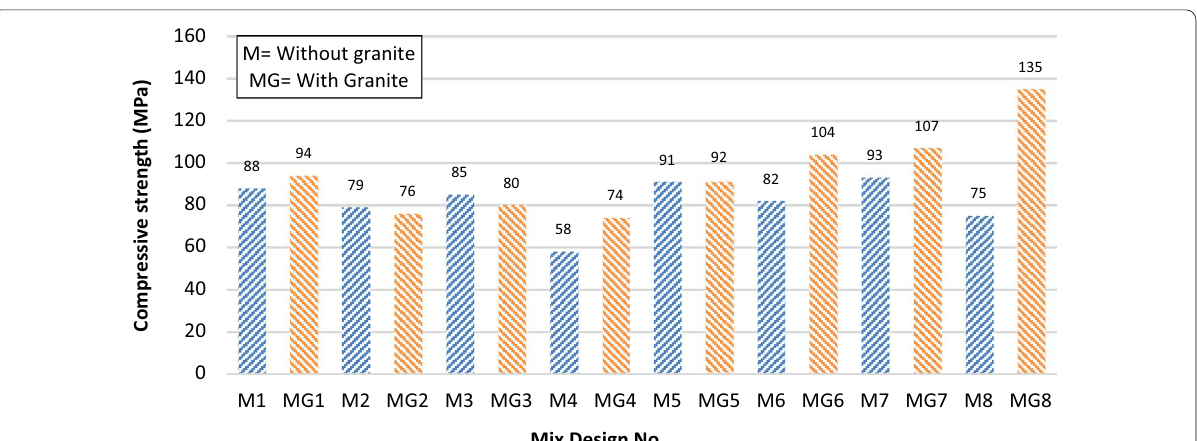
Fig. 4 Compressive strength of mixes with and without GW after heating